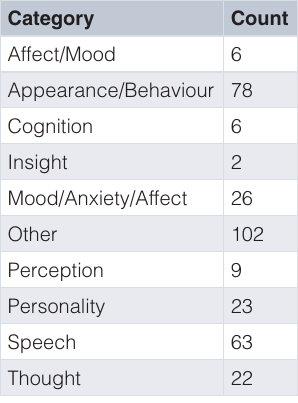
Table 2. Counts of terms where annotators independently agreed by